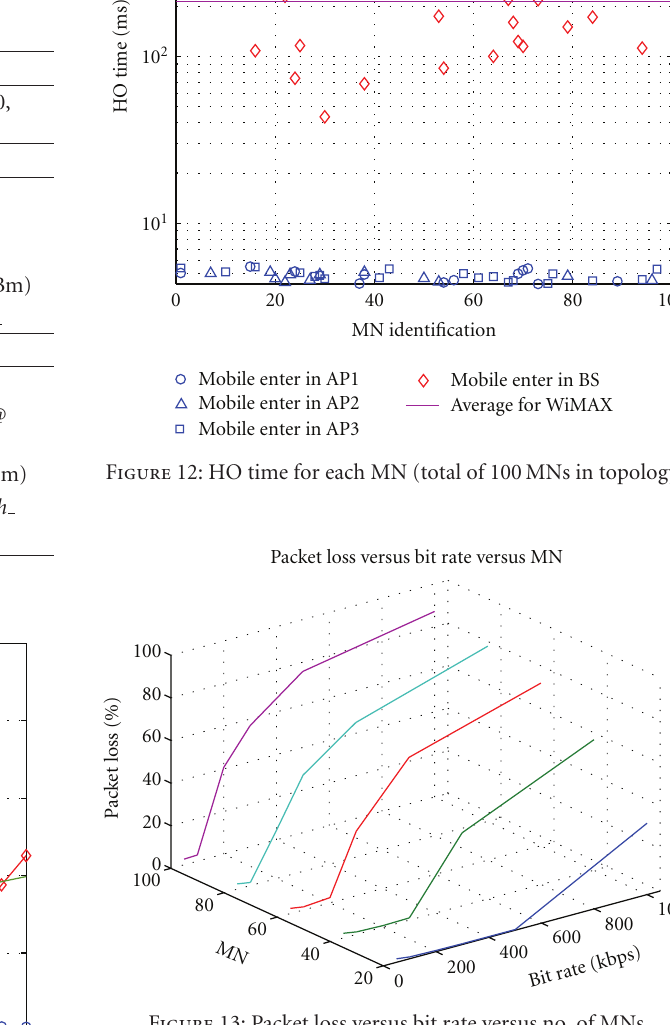
Figure 13: Packet loss versus bit rate versus no. of